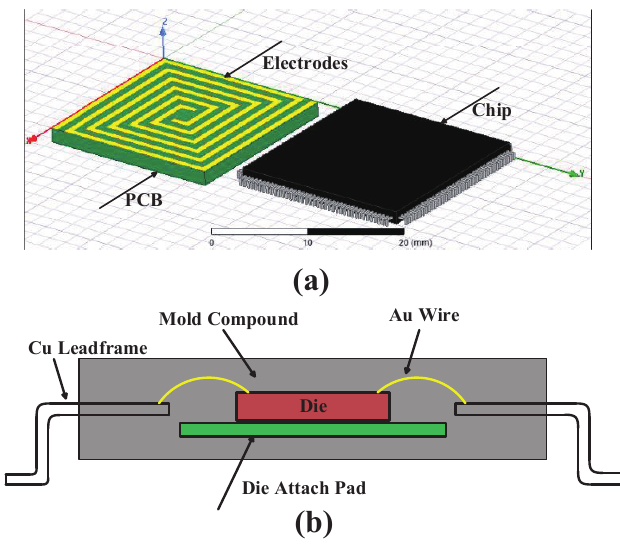
Figure 4. ( a ) is a model of simulation in Ansoft Maxwell 3D; ( b ) is a package model.